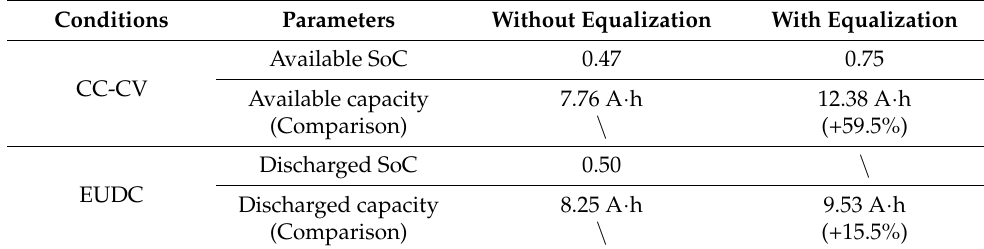
Figure 15. Equalization experiment based on VSSGPC strategy in EUDC operating condition: ( a ) Voltage; ( b ) SoC. Table 7. Comparison of charging and discharging operating